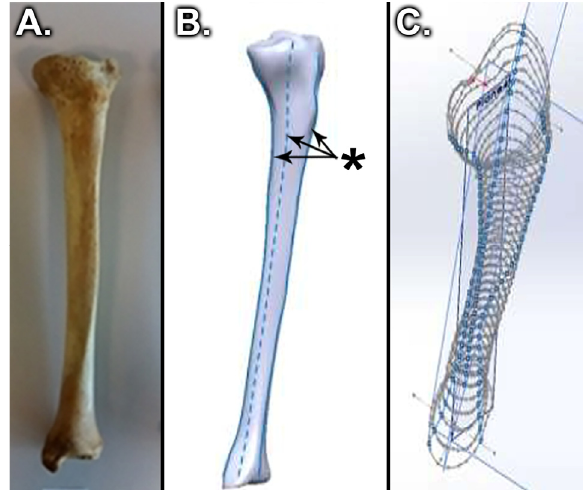
Figure 2. Conversion of a real tibial bone to a virtual model [35]: ( A ) Tibial bone, ( B ) Scanned model of the tibial bone with guidelines for creating the virtual model, ( * ) – marks on scanned model and used as guidelines for creating the virtual model, ( C ) Virtual tibial bone model during processing.